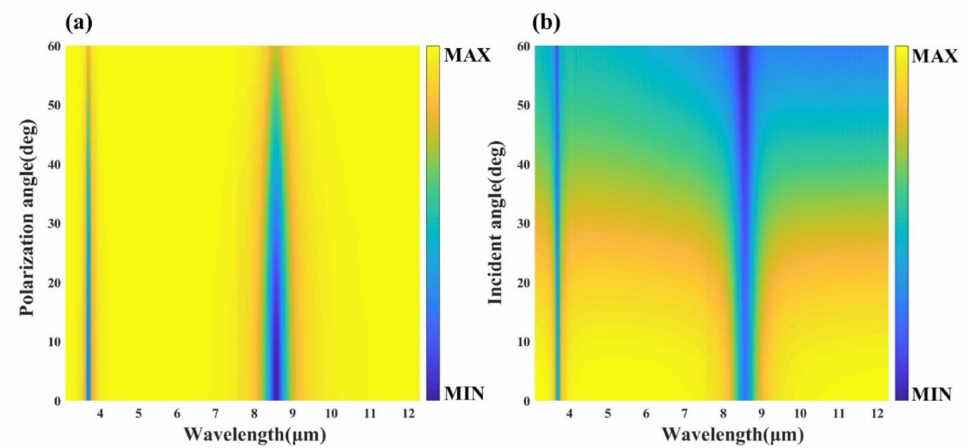
Figure 4. Reflectance spectra of the proposed four-layer structure in the infrared band ( a ) at different polarization angles and ( b ) at different incident